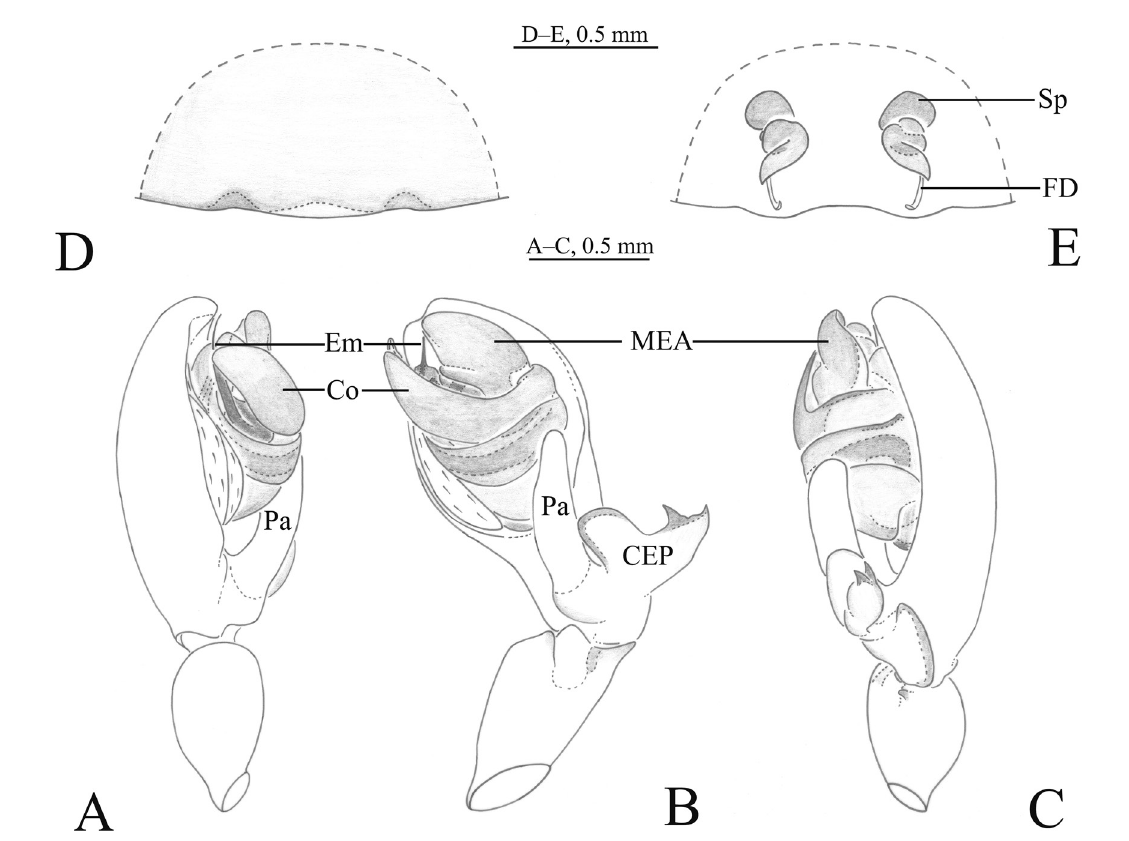
Fig. 13. Meta tibet sp. nov. A–C . ♂, holotype (SWUC-T-TEg-06-01). D–E . ♀, paratype (SWUC-T- TEg-06-05). A . Left palp, prolateral view. B . Same, ventral view. C . Same, retrolateral view. D . Epigyne, ventral view. E . Vulva, dorsal